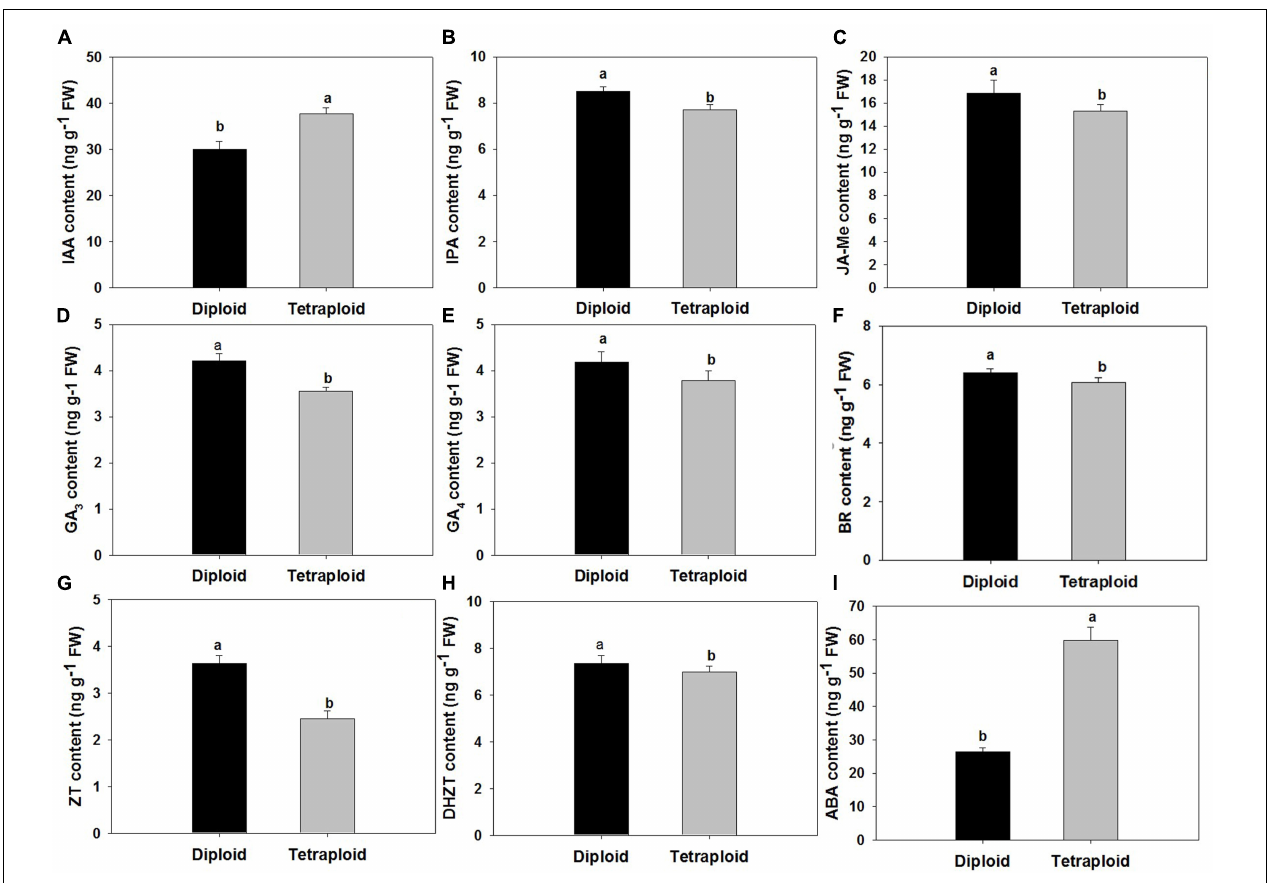
FIGURE 8 | Comparison of endogenous hormone levels. (A) Indole-3-acetic acid (IAA). (B) Isopentenyladenosine (IPA). (C) Methyl Jasmonate (MeJA). (D) Gibberellins (GA 3 ) (E) Gibberellins (GA 4 ). (F) Brassinosteroid (BR). (G) Zeatin (ZT). (H) Dihydrozeatin (DHZT). (I) Abscisic acid